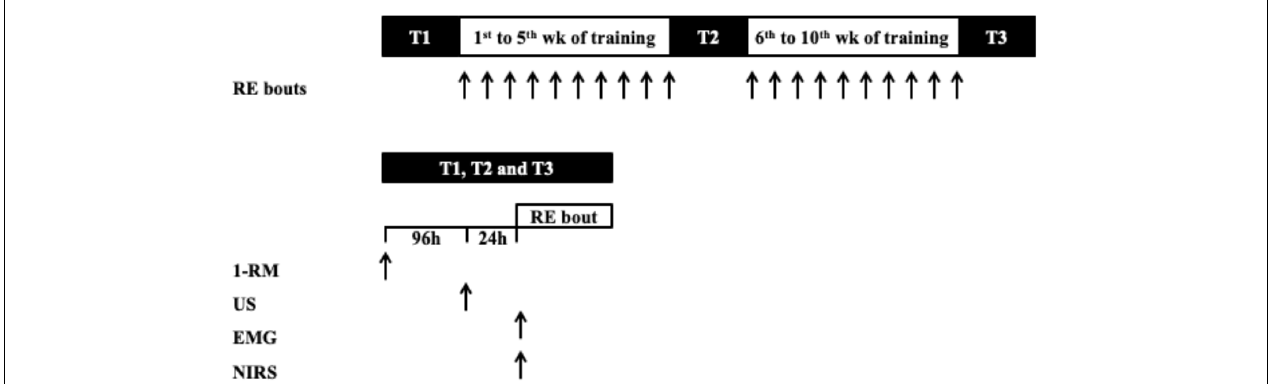
FIGURE 1 | Schematic of study protocol. RE, resistance exercise; 1-RM, one-repetition maximum; EMG, electromyographic; NIRS, near-infrared spectroscopy.